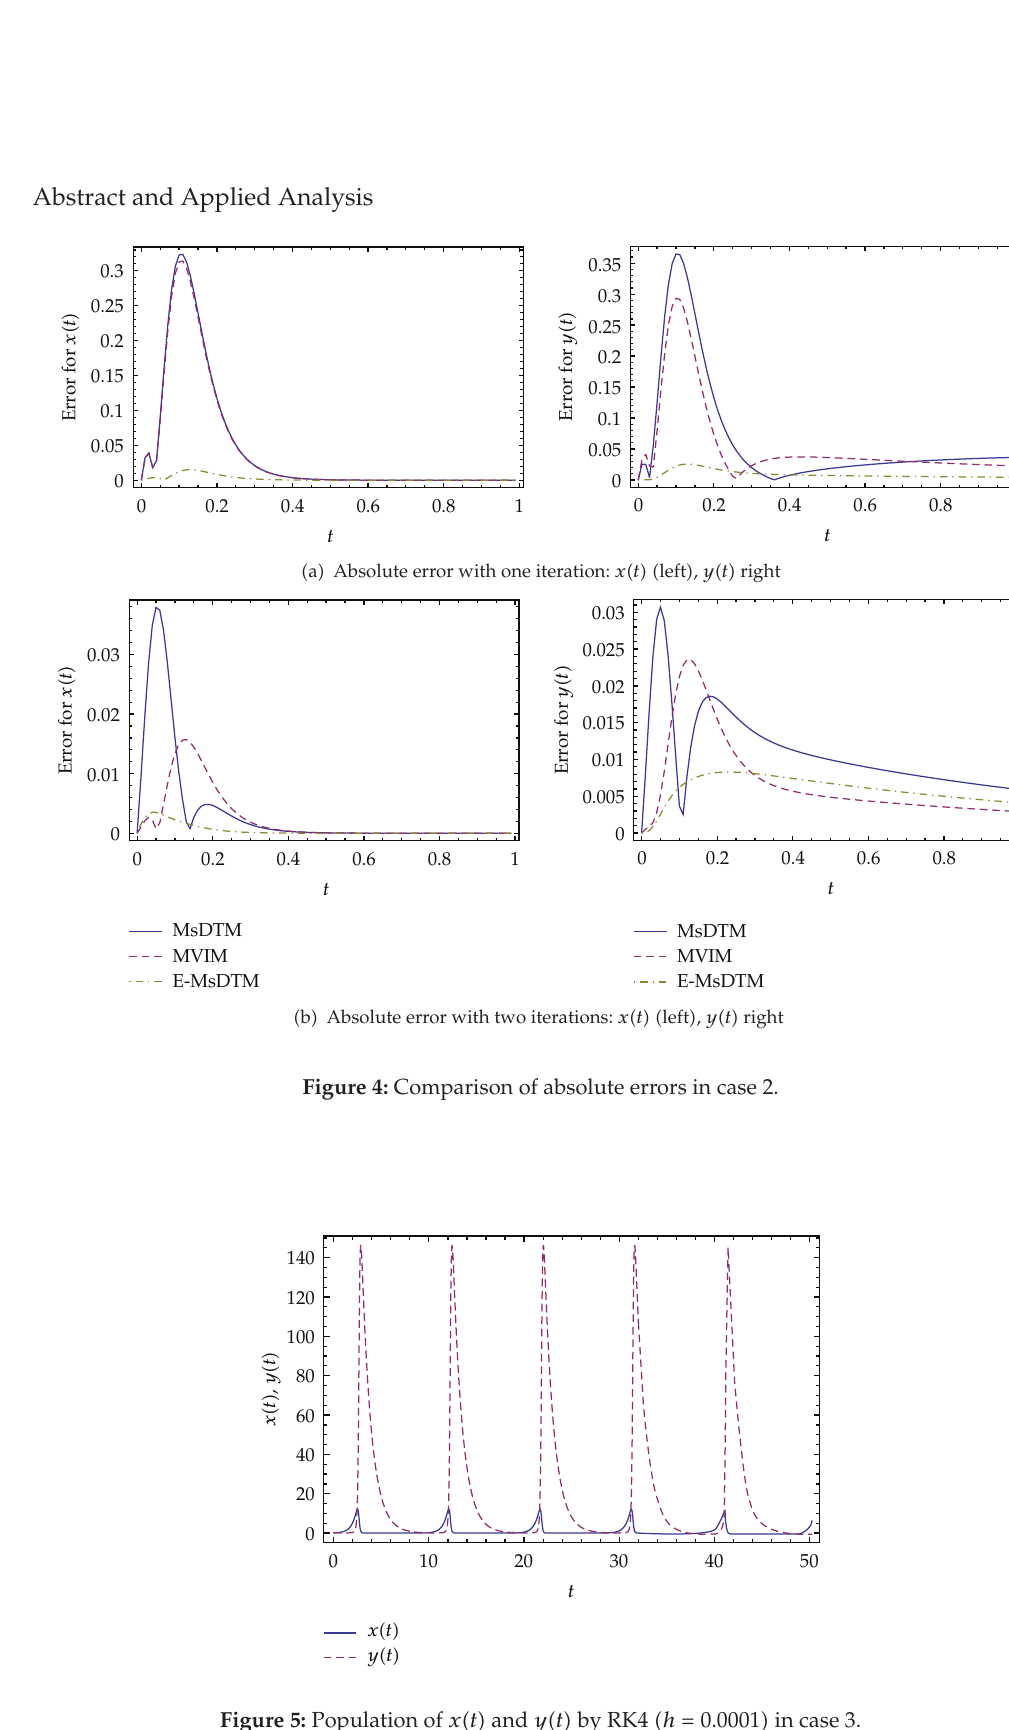
Figure 5: Population of x (cid:4) t (cid:5) and y (cid:4) t (cid:5) by RK4 (cid:4) h (cid:8) 0 . 0001 (cid:5) in case